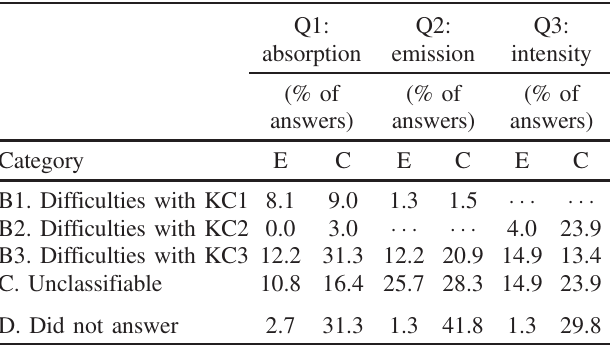
TABLE V. Percentages of learning difficulties in experimental students (E) and control students